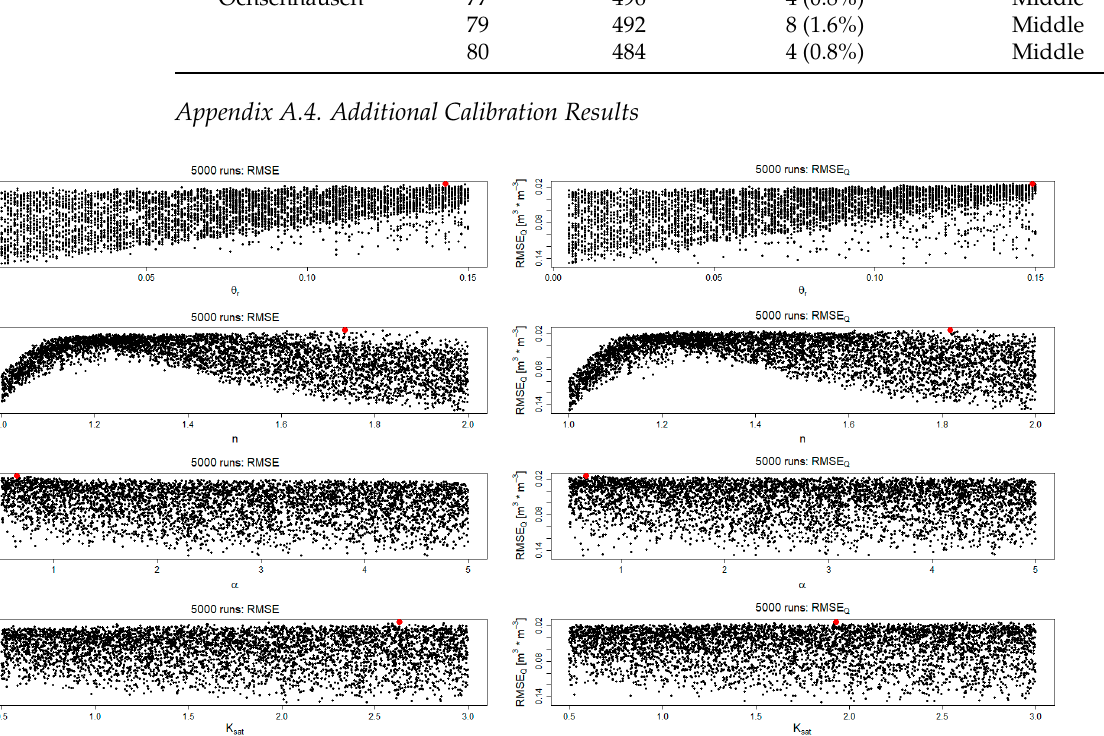
Figure A2. The 5000 MC calibration runs for θ r (m 3 × m − 3 ), n ( − ), α (m − 1 ), K sat (m × day − 1 ) on the RMSE and RMSE Q delivered the following results, with red dots marking the lowest RMSE or RMSE Q .